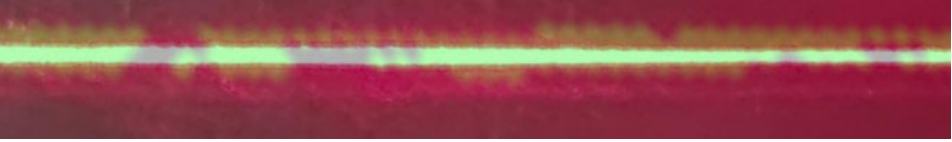
Figure 8. Line ‐ structured light identifies the discontinuous regions. Figure 8. Line-structured light identifies the discontinuous regions.